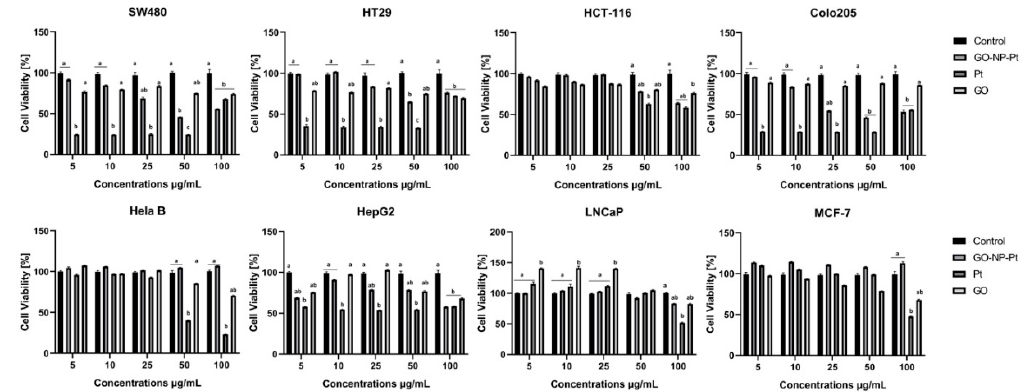
Figure 4. Effects nanocomplexes of graphene oxide and platinum nanoparticles, platinum nanoparticles, and graphene oxide on cell viability. Notes: Different lowercase letters (a and b) within columns indicate significant differences between the concentrations (P < 0.05). Abbreviations: GO-NP-Pt — nanocomplexes of graphene oxide and platinum nanoparticles, NP-Pt — platinum nanoparticles, GO — graphene oxide.